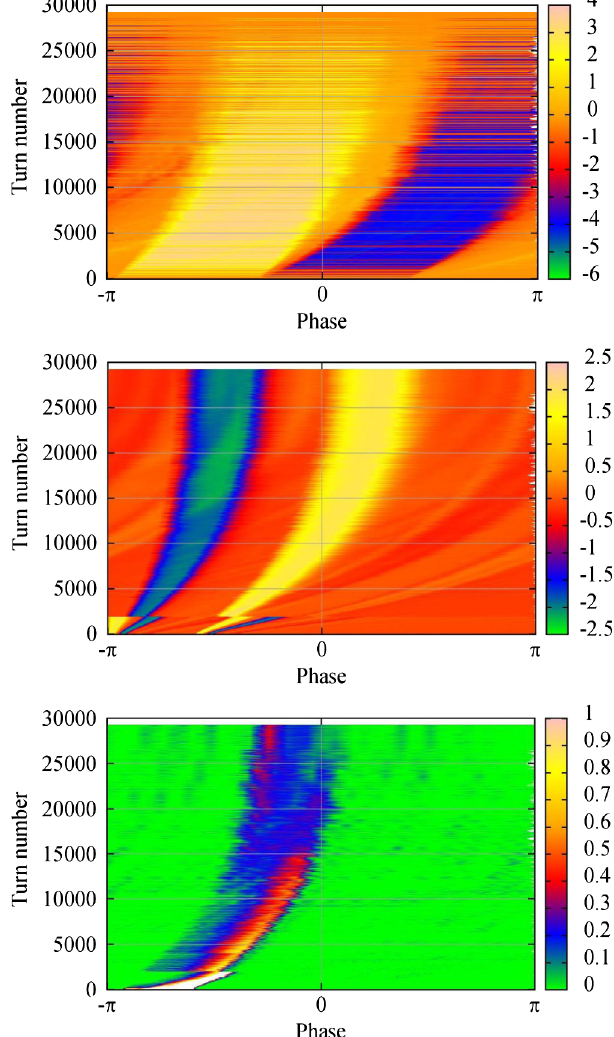
¼ 0 . 5 TofcaseII, V FIG. 5 (color online). For B max (middle), and bunch signal (bottom), where the horizontal axis is phaseandtheverticalaxisisturnnumber,inadditionyellowandblue in V and V denote set voltages and reset voltages, acc bb